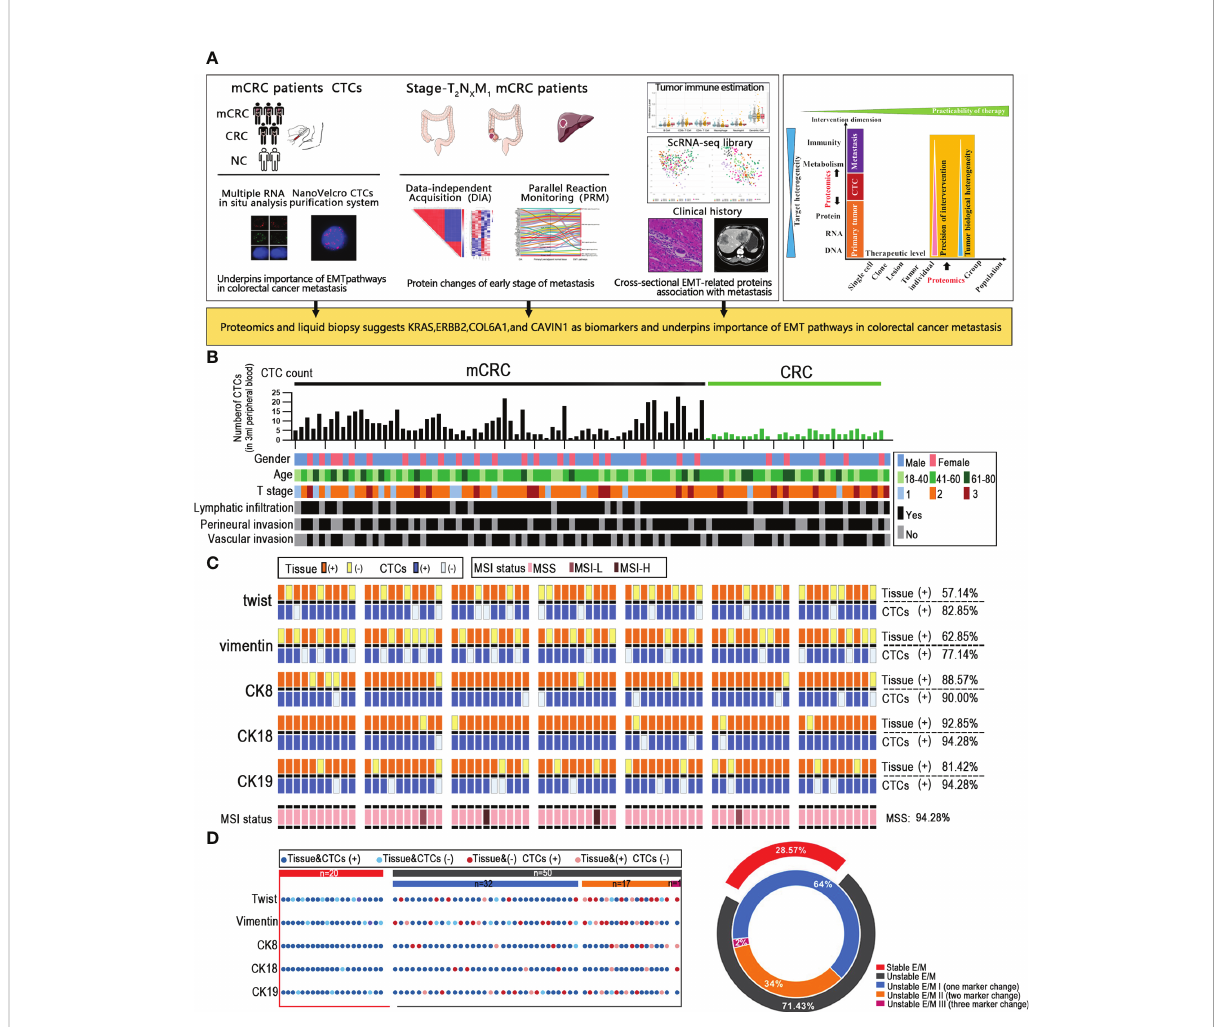
FIGURE 1 Unstable tumor and CTCs EMT state correlate with the clinical outcome of mCRC patients. (A) A scheme showing experiments and integrated analyses which were performed. (B) CTCs pro fi le and associated clinicopathologic features of all the mCRC patients and CRC patients. (C) The landscape of EMT molecular alterations detected in CTCs and the alterations detected in paired tissue samples is presented. (D) Shown are proportions of stability molecular expression CTCs in individual patients; red: stable, gray: